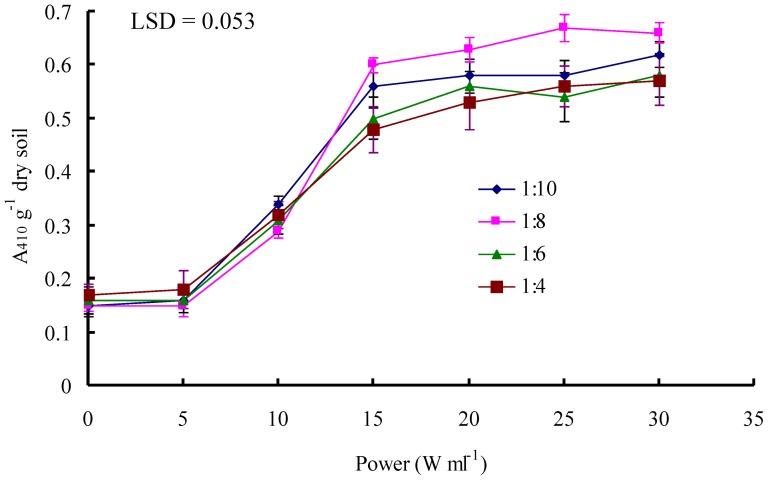
Absorbance (410 nm) of supernatants of soil slurries after 300 s sonication at different extraction ratios as a function of power density.